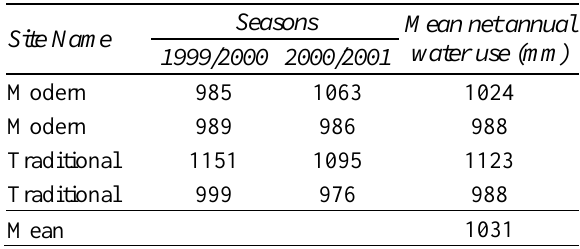
Table 1: Net annual water use (NAWU) by rice plant in different irrigation